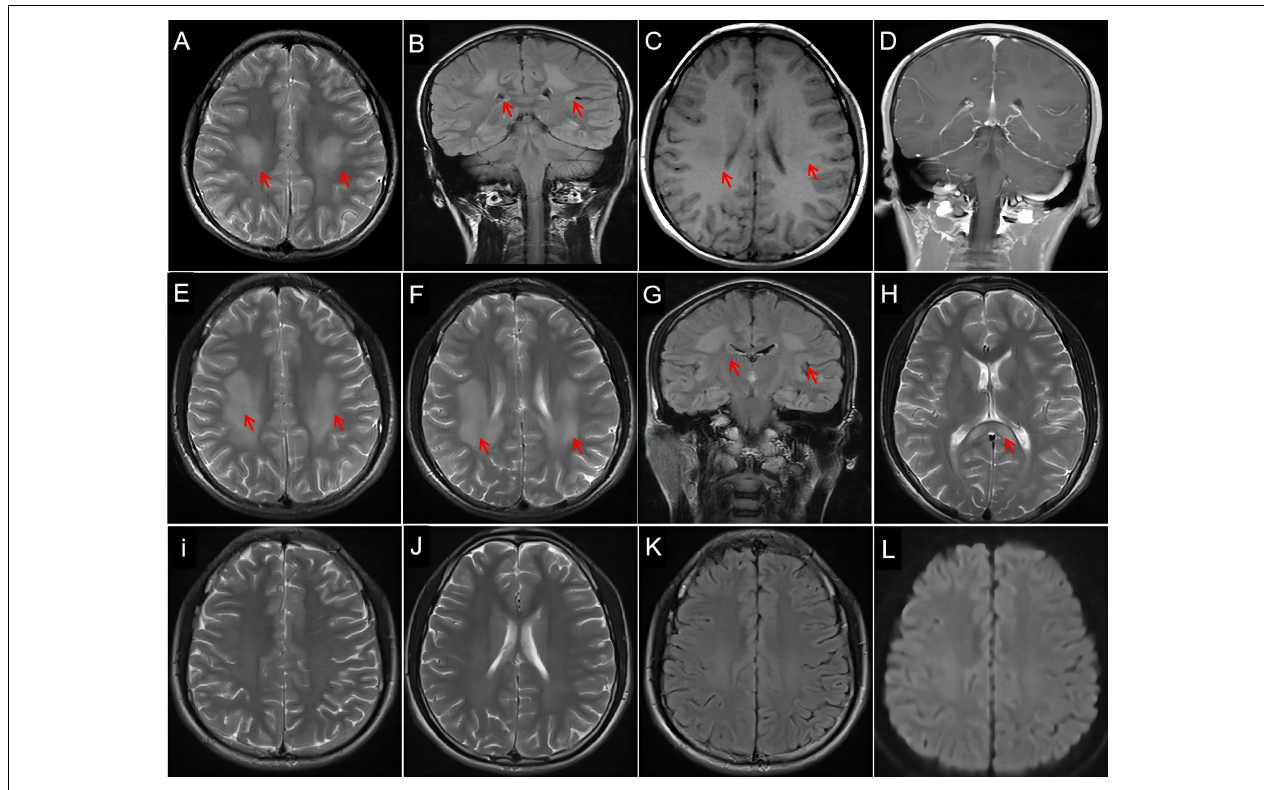
FIGURE 1 | Evolution of lesions on brain magnetic resonance imaging (MRI). Hyperintensity lesions (arrows) in centrum semiovale and corona radiata on axial T2-weighted imaging (WI, A ) and coronal T2-WI ( B , arrows), hypointense lesions on T1-WI ( C , arrows), and isointensity on contrast-enhanced MRI (D) . MRI reveals more hyperintensity signals in bilateral centrum semiovale ( E , arrows), corona radiata ( F,G , arrows), and corpus callosum ( H , arrows) on T2-WI than before. Three months later, repeated MRI shows complete disappearance of the abnormal white matter signal on T2-WI (I,J) , fluid-attenuated inversion recovery imaging (K) , and diffusion WI (L) .